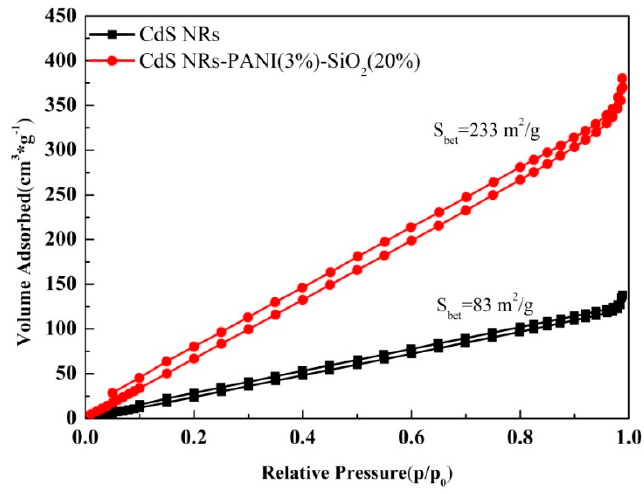
Figure 3. N 2 adsorption–desorption isotherms of the catalysts.